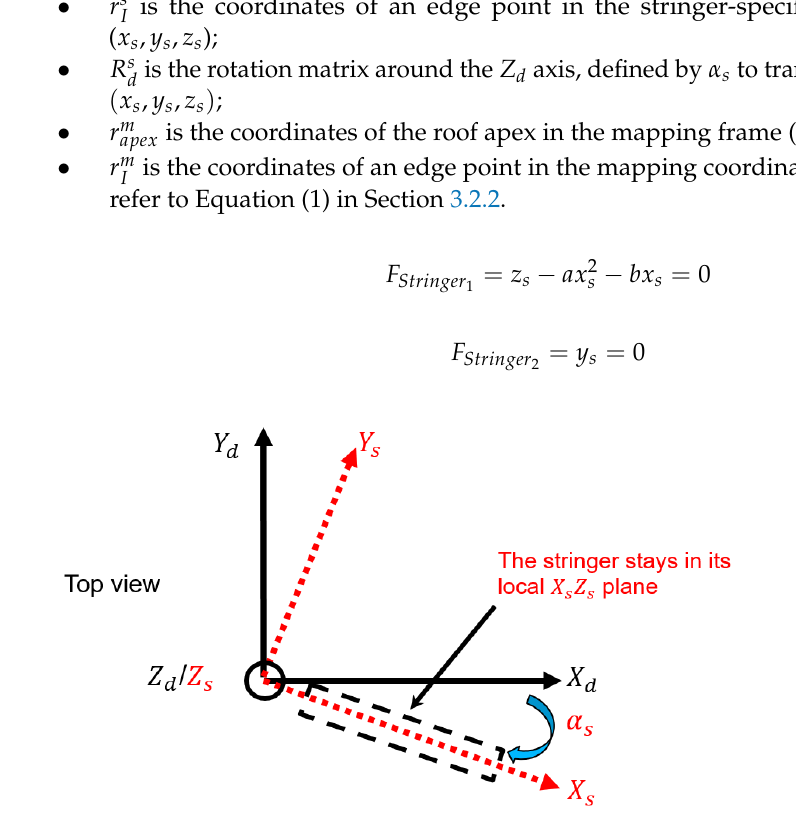
Figure 25. Illustration of the stringer-specific coordinate system.